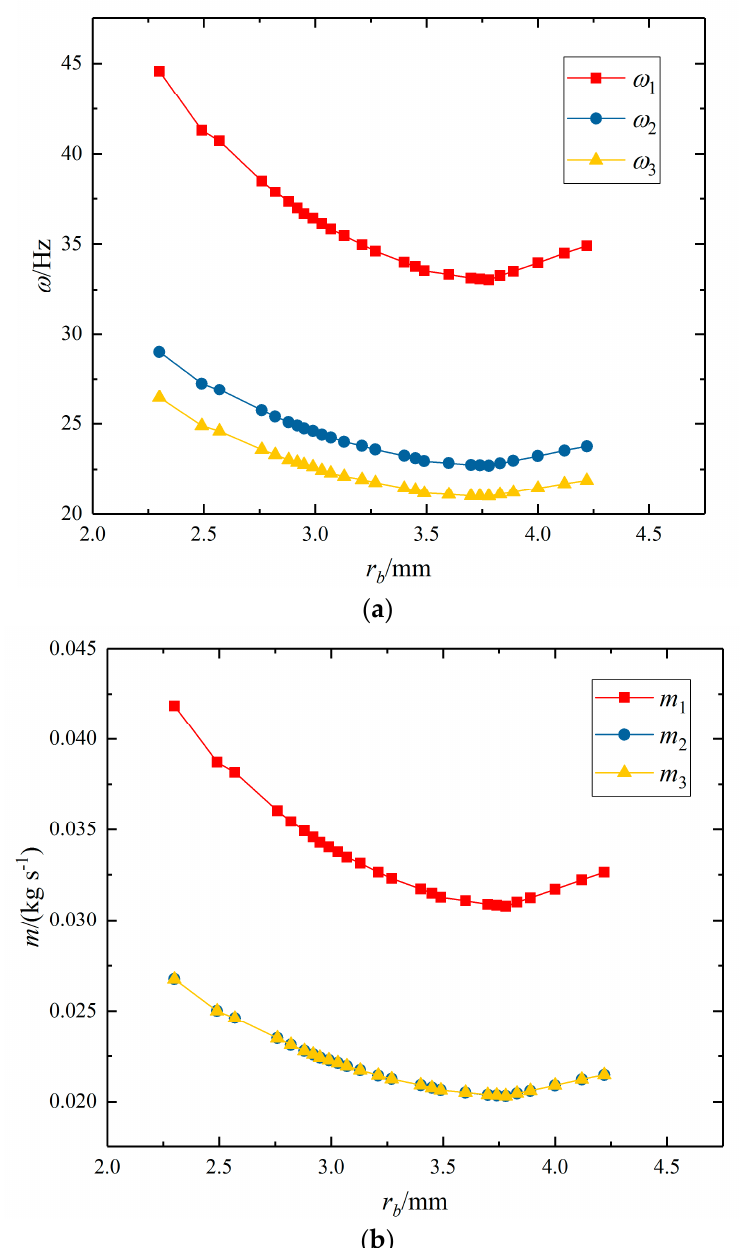
Figure 10. ( a ) Optimal frequencies of VSPs. ( b ) Optimal mass flow rates in loops under different r b .